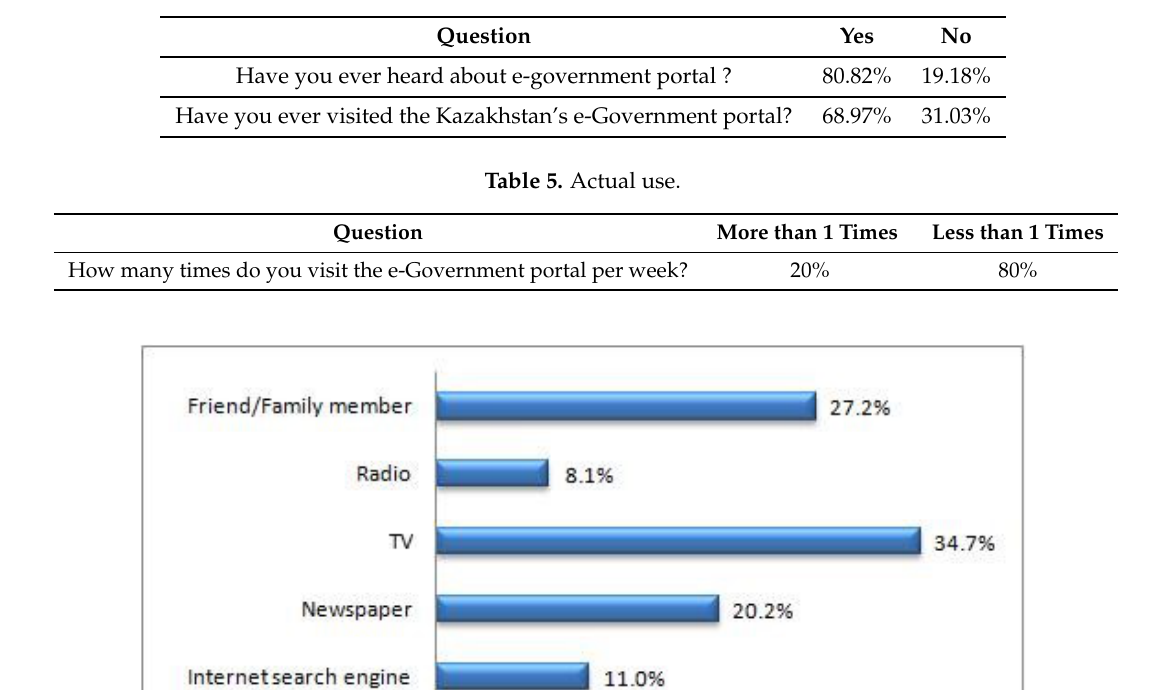
Table 4. Awareness of the portal.